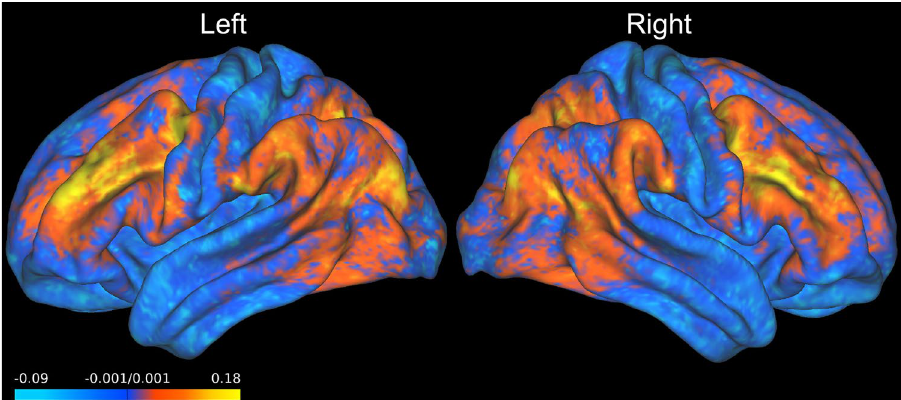
2 Figure 5. Mean R Score of MMP-RR-PCR across all contrast targets. Plotted are the R the 100 test subjects. This is rendered on the a 200 subject averaged midthickness surface map of left and right cortical hemispheres. Positive values (red and yellow) indicate where prediction is possible. Note that prediction accuracy is best outside the primary sensory regions.